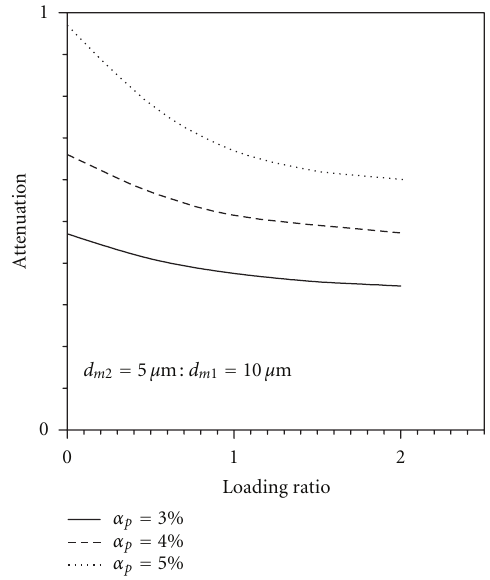
Figure 13: Nondimensional attenuation as function of particle diameter and loading distribution [ α p 2 : α p 1 ] for two sets of particles (10 μ m [ d m 1 ] and 5 μ m [ d m 2 ] particles), reference motor, acceleration